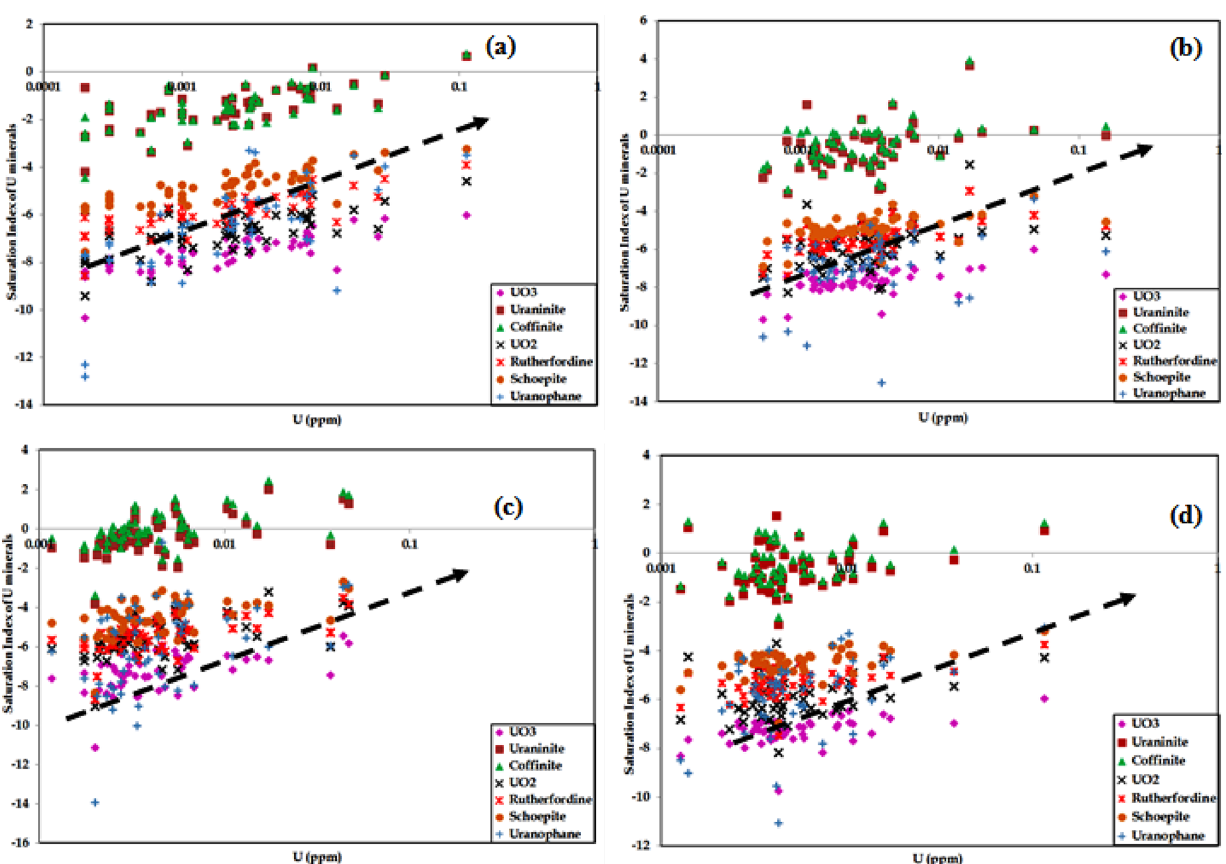
Fig. 13 Variation of saturation index of U minerals with total U for a PRM, b SWM, c NEM and d